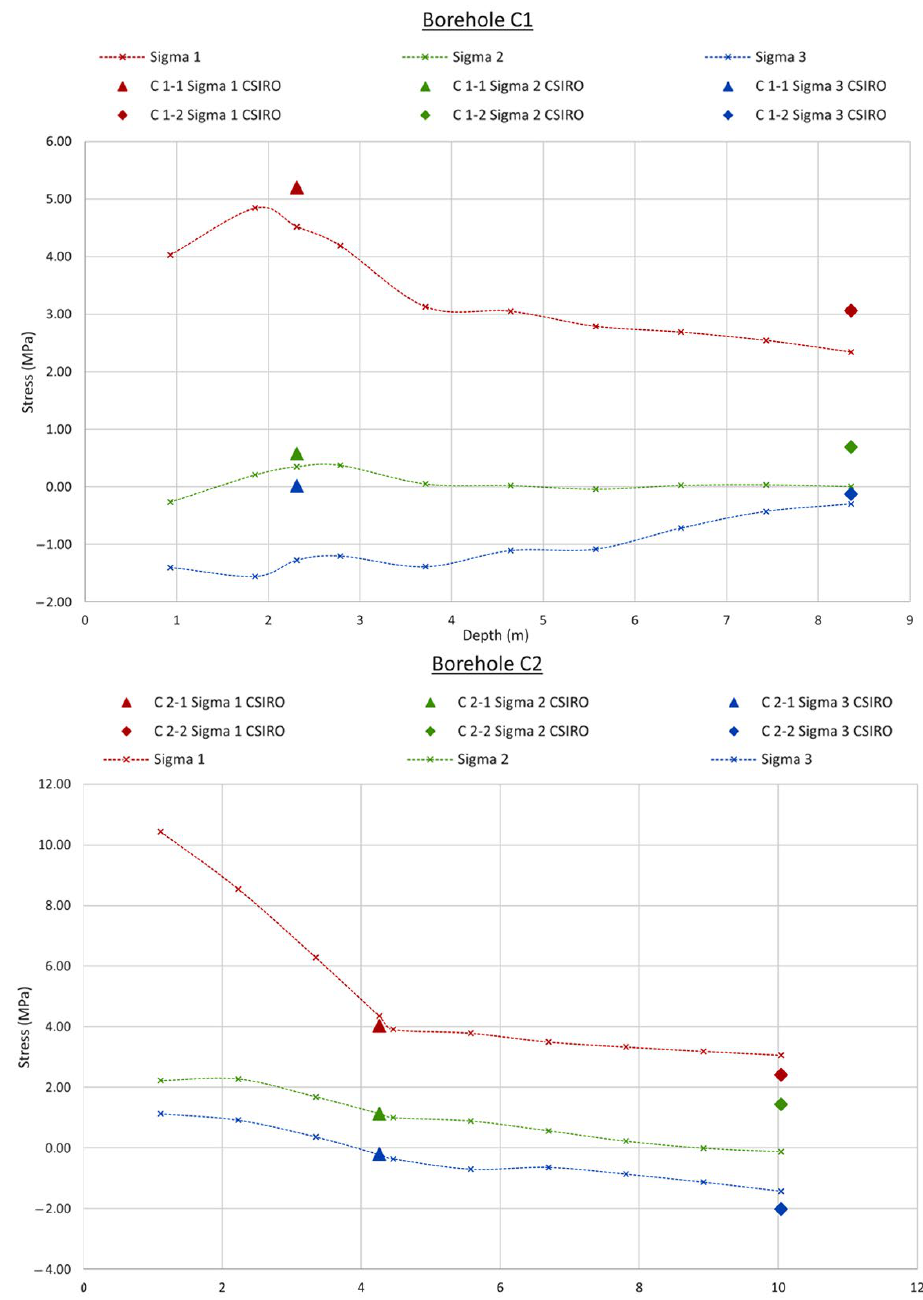
Figure 15. Trend of the principal stresses ( σ 1 , σ 2 , and σ 3 ) versus the depth of C1 and C2 boreholes after model calibration (dotted lines) and their punctual values as obtained from the in situ CSIRO HI cell measurements (triangles and rhombuses).